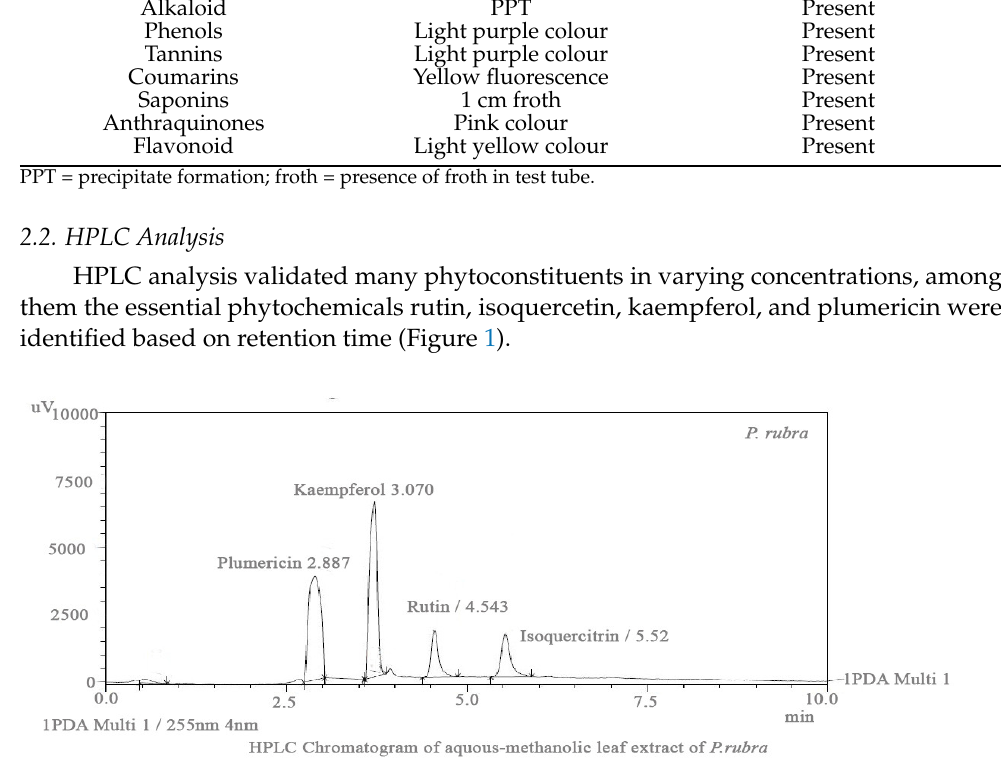
Figure 1. HPLC chromatogram of aqueous-methanolic leaf extract of P. rubra showing the rutin, isoquercetin, kaempferol and plumericin with reference to retention time of standard.